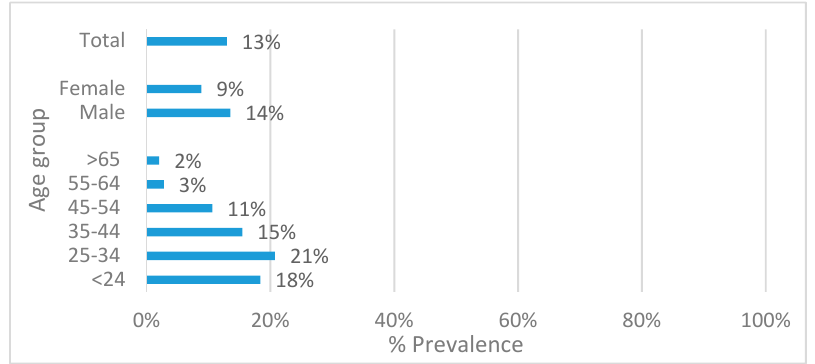
Figure 1. Total prevalence of oral mucosal lesions according to sex ( p = 0.003), age group ( p < 0.001), and total.